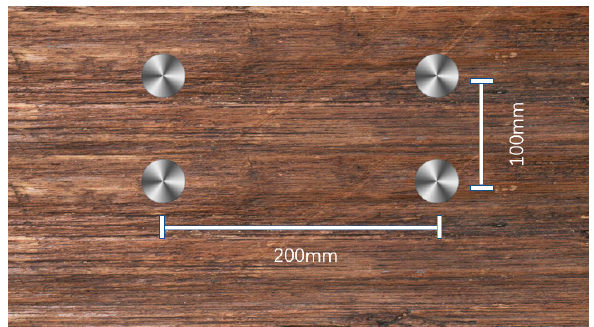
Figure 2. Sensors installation location diagram.